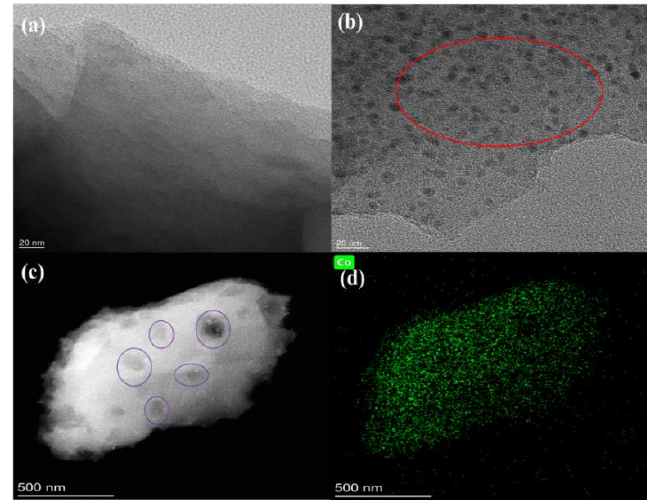
Figure 1. SEM and related EDS element layered images of D001CB ( a ); Co/D001CB ( c ); and N- Co/D001CB ( c ). Figure 2. TEM diagrams of D001CB ( a ); and N-Co/D001CB ( b ); EDS layered mapping diagram of cobalt elements ( c , d ).